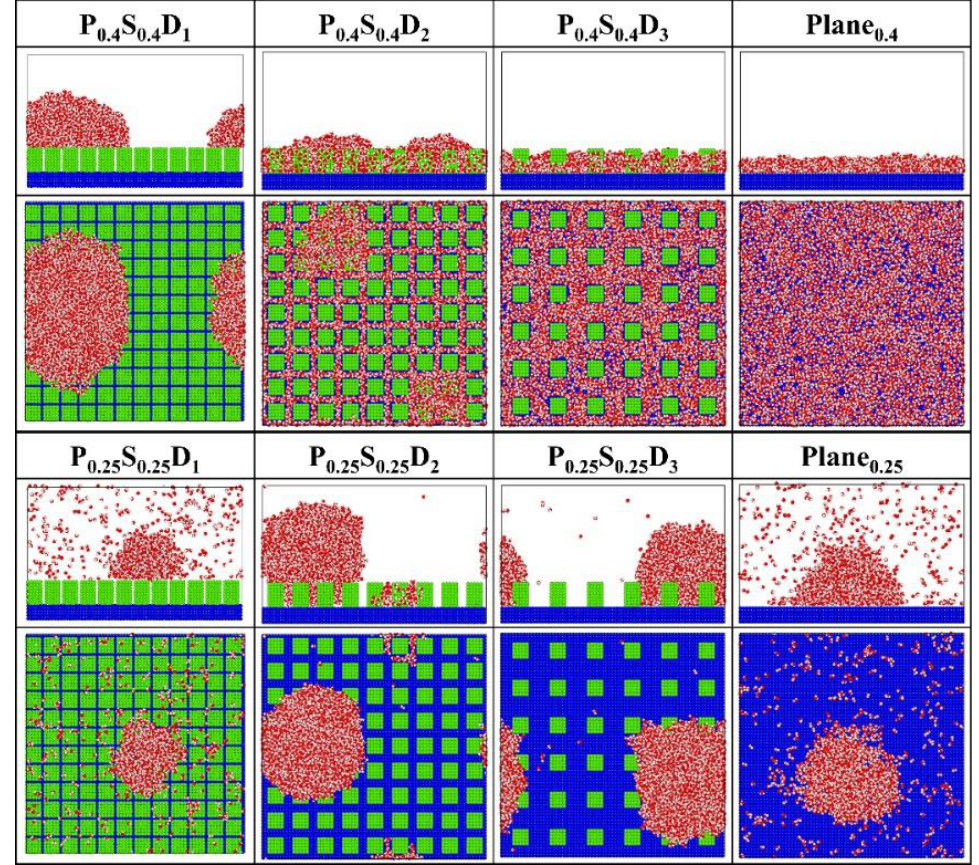
Figure 4. The snapshot of the condensate formed on the surfaces with uniform wettability at the end of the simulation.